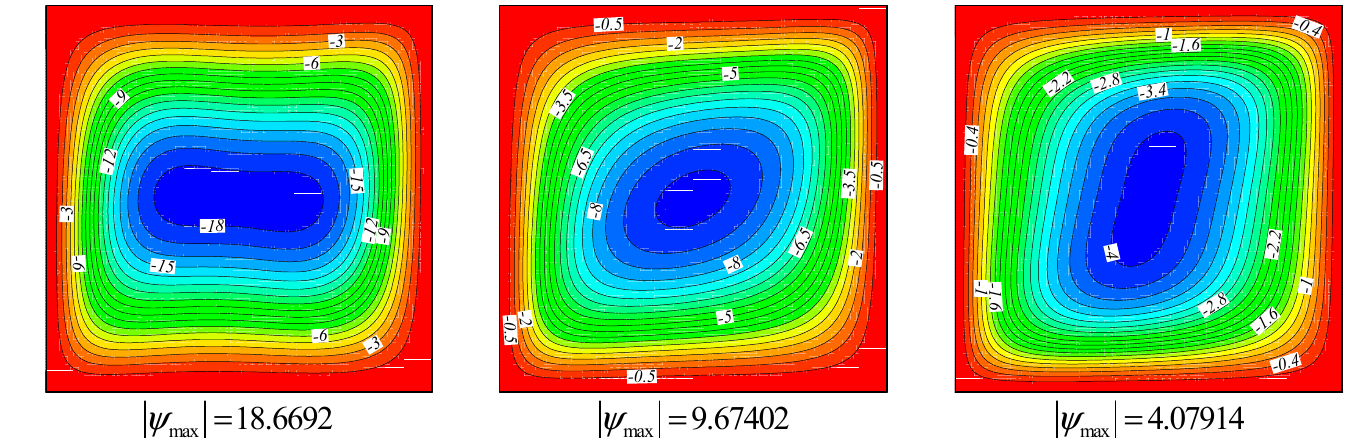
φ = 2%. φ = 2%. Figure 2. Streamline contours for different values of Rayleigh and Hartmann numbers when N = 1, m = 3, and φ = 2%.